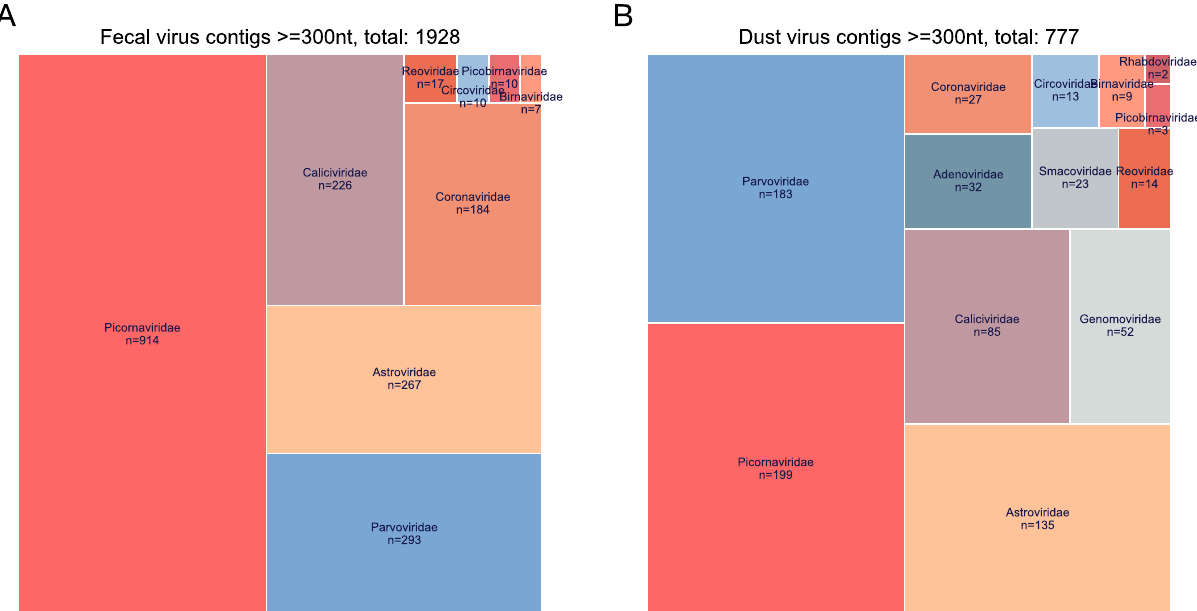
Figure 1. An overview treemap of the number of viral contigs detected in all chicken fecal samples ( A ) and all chicken farm dust samples ( B ). The size of each virus family sector is proportional to the number of contigs detected in the family (= number of contigs in this family/total number contigs observed). Only viral contigs with minimum length of 300 nt, at least 70% identity to the reference sequences and a detection e-value threshold of < 1 × 10 –10 when comparing with the closest reference sequence in our database were included.